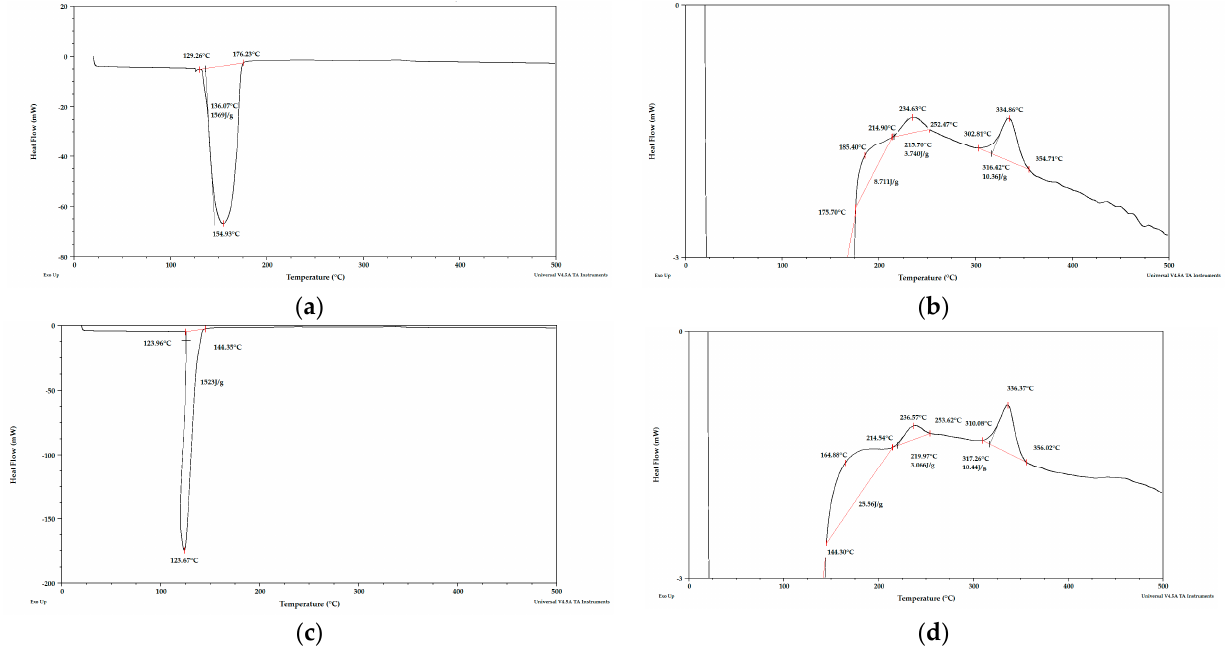
Figure 6. DSC curves for fresh apple pomace ( a ) sample 1, ( b ) sample 1 enlarged, ( c ) sample 2, ( d )